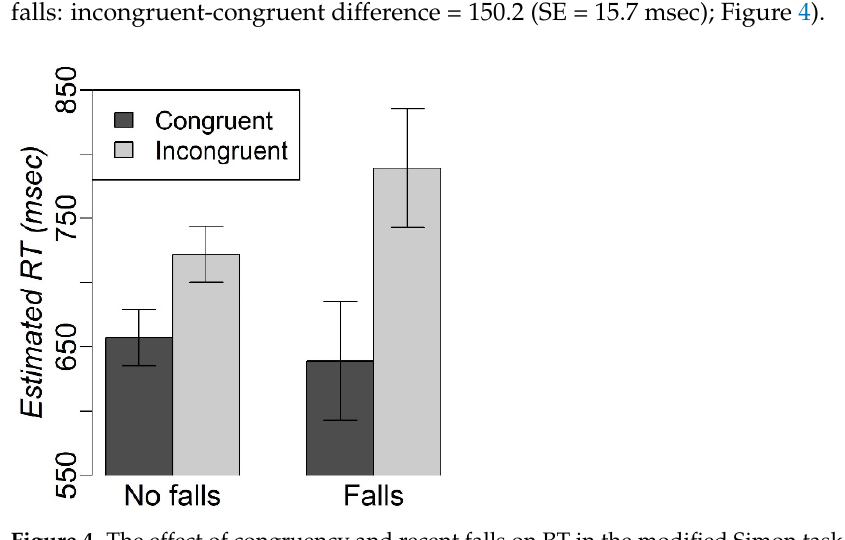
Figure 4. The effect of congruency and recent falls on RT in the modified Simon